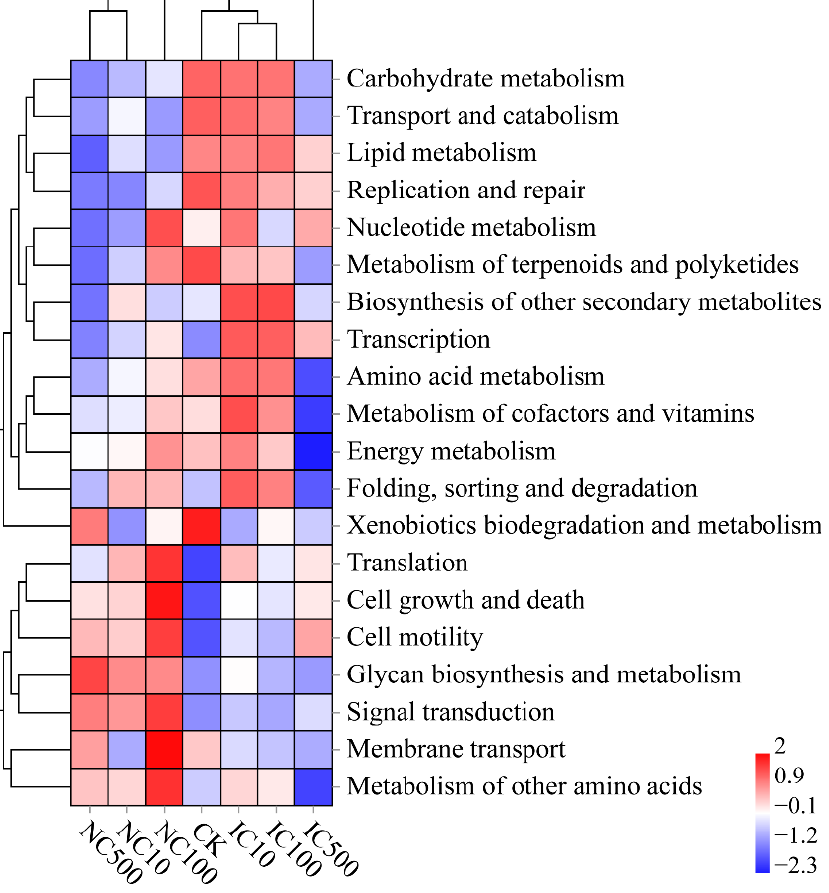
Figure 8. Hierarchical clustering heatmap of predicted bacterial phenotypic traits by BugBase. The heatmap is based on the standardized phenotypic trait abundance data. Warmer color (red)